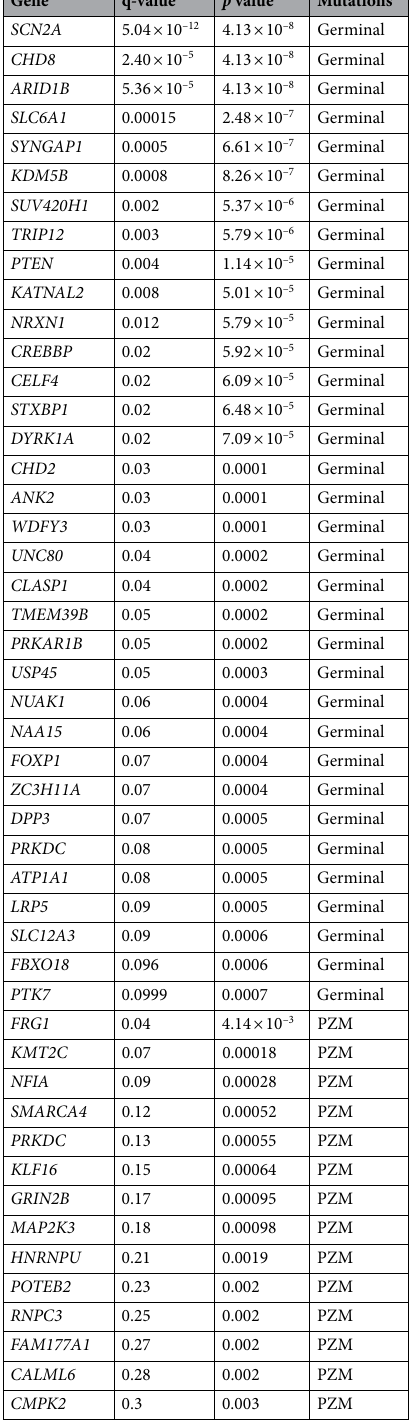
Table 2. ASD risk genes carrying germinal DNMs and PZMs in the combined cohort. p values and q-values were obtained after running TADA-Denovo using germinal DNMs and PZMs from the combined cohort (N = 2103). Genes with q-values < 0.1 are shown in the case of germinal DNMs and genes with q-value < 0.3 are shown in the case of